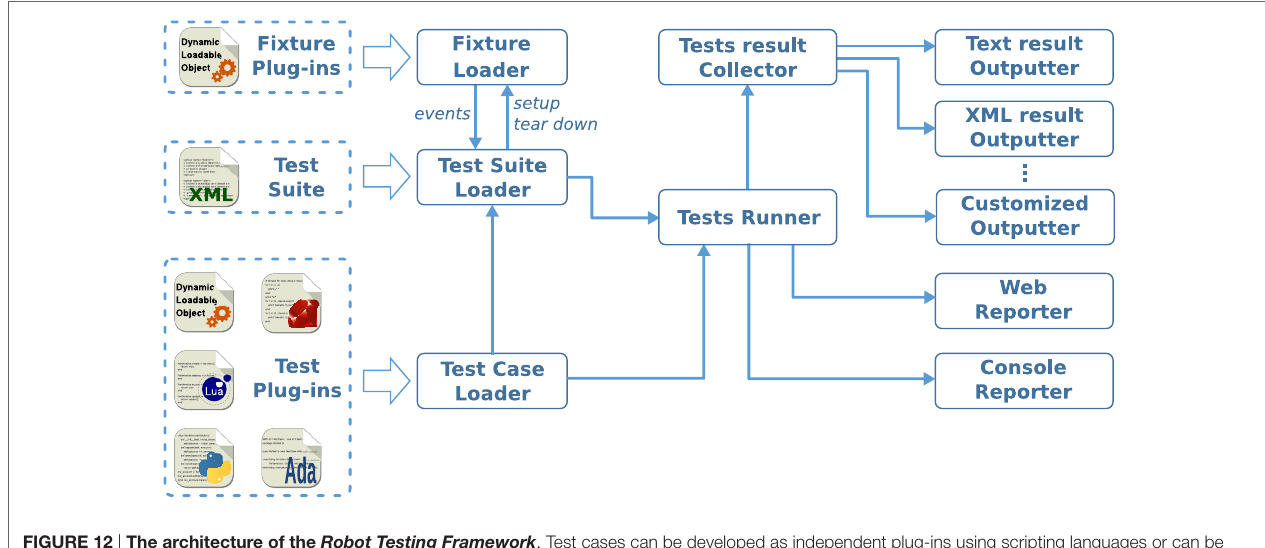
FigUre 12 | The architecture of the Robot Testing Framework . Test cases can be developed as independent plug-ins using scripting languages or can be built as dynamically loadable libraries. The plug-ins are loaded by the Test Case Loader and are executed by the Test Runner . Test cases can also be grouped in different test suites, which are represented using XML. In the latter case, the Test Suite Loader parses the XML file and, using the Test Case Loaders , it loads the corresponding test plug-ins. Each test suit can optionally have a fixture manager, which is implemented as a separate plug-in (which is loaded by the Fixture Loader ). This fixture plug-in is responsible for setting up the fixture and informing the Test Suite Loader when the fixture fails (e.g., crashes). In this case, the Test Suite Loader restarts the fixture and resumes execution of the remaining test cases. The result of the tests can be monitored from the console (through the Console Reporter ) or remotely from a Web browser (through the Web Reporter ). The Test Result Collector allows storing data in different formats. For example, this figure shows two components for storing output in text format or XML, ( Text result Outputter and XML Result Outputter ,